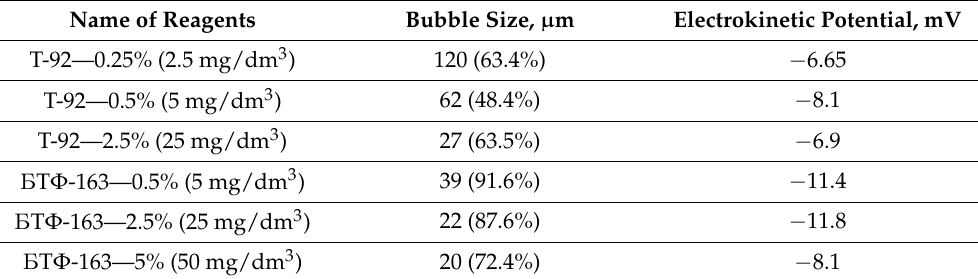
Table 5. The size of WAME and the electrokinetic potential of reagent solution.